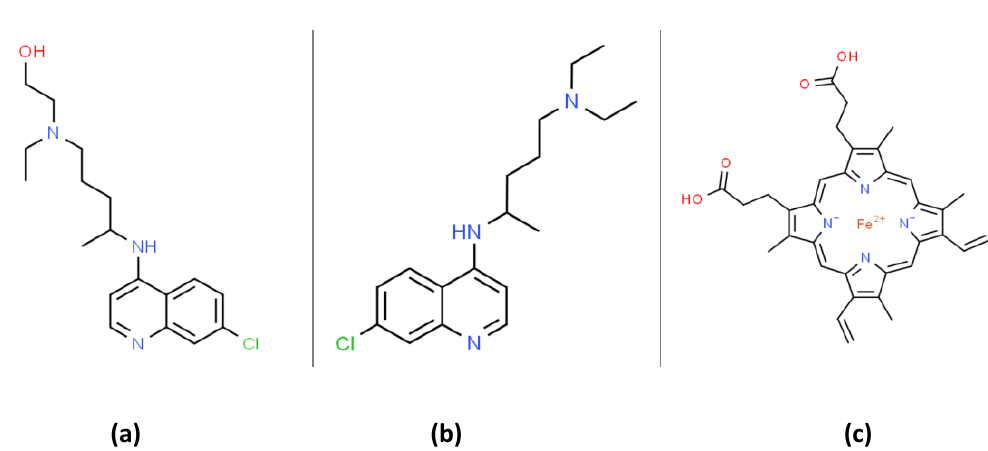
Figure 1. The organic structures of ( a ) hydroxychloroquine (HCQ); ( b ) chloroquine and; ( c ) heme. Chloroquine can form a membrane bound complex with heme that can promote lipid peroxidation (see Figure 4 and text).